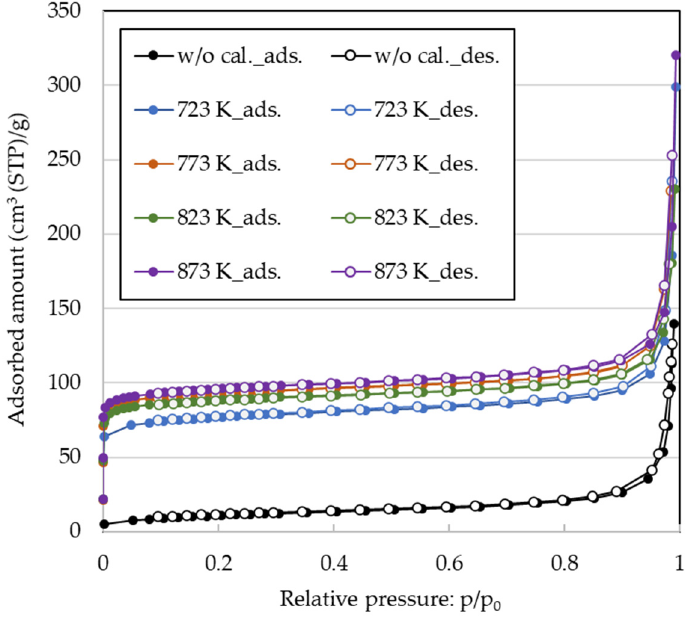
Figure 4. N 2 adsorption–desorption isotherms for 720NHA (FER) at 77 K. The structural parameters of 720NHA (FER), 840NHA (MFI), and 940HOA (BEA) obtained from the N 2 adsorption–desorption isotherms are listed in Table 3. 940HOA (BEA) had the largest total surface area (757–823 m 2 /g), micropore surface area (741–804 m 2 /g), and micropore pore volume (0.24–0.26 cm 3 /g). 720NHA (FER) showed the highest values for the external surface area (25–29 m 2 /g) and total pore volume (0.21–0.38 cm 3 /g). 840NHA (MFI) showed intermediate values among the three zeolites. Table 3. Pore parameters for 720NHA (FER), 840NHA (MFI), and 940HOA (BEA) at different calcination temperatures. Material Topology